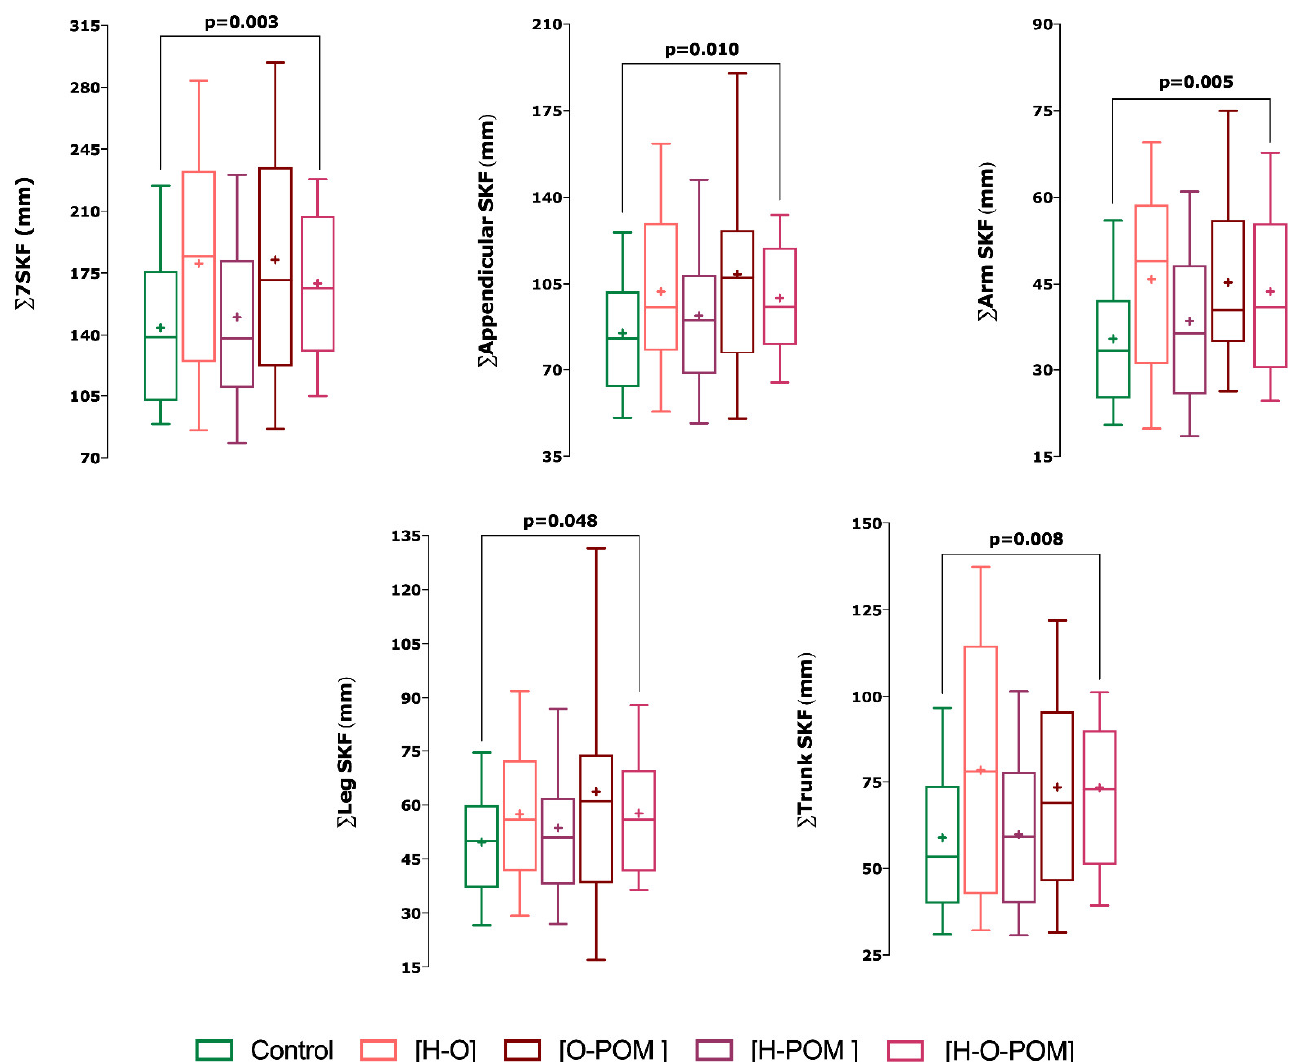
Figure 2. Differences in skinfold measurements between control and PCOS subjects. An ANCOVA was used to assess differences among the groups ( p < 0.05 two tailed). p -value adjusted by Age and Body Mass lndex. Phenotypic: Hyper- androgenism [H]; oligo/amenorrhoea [O]; polycystic ovarian morphology [POM]. Anthropometric: ∑7SKF (mm). Sum of seven skinfolds [triceps + subscapular + biceps + suprailiac + abdominal + thigh + Meanl calf (mm)]; ∑Appendicular SKF (mm). Sum of appendicular skinfolds [triceps + biceps + thigh + Meanl calf (mm); ∑Arm SKF (mm). Sum of arm skinfolds [triceps + biceps (mm)]; ∑Leg SKF (mm). Sum of leg skinfolds [thigh + mean calf (mm)]; ∑Trunk SKF (mm). Sum of trunk skinfolds [subscapular + suprailiac + abdominal (mm)].